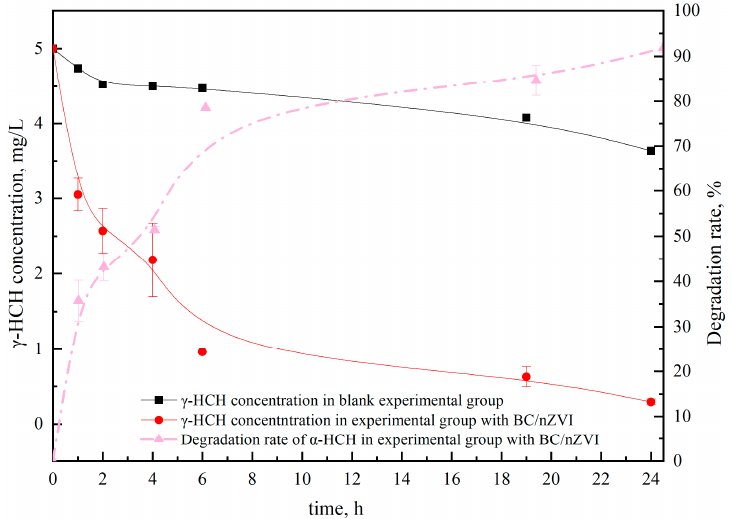
Figure 3. Effects of BC/nZVI material on the degradation of γ -HCH in water.